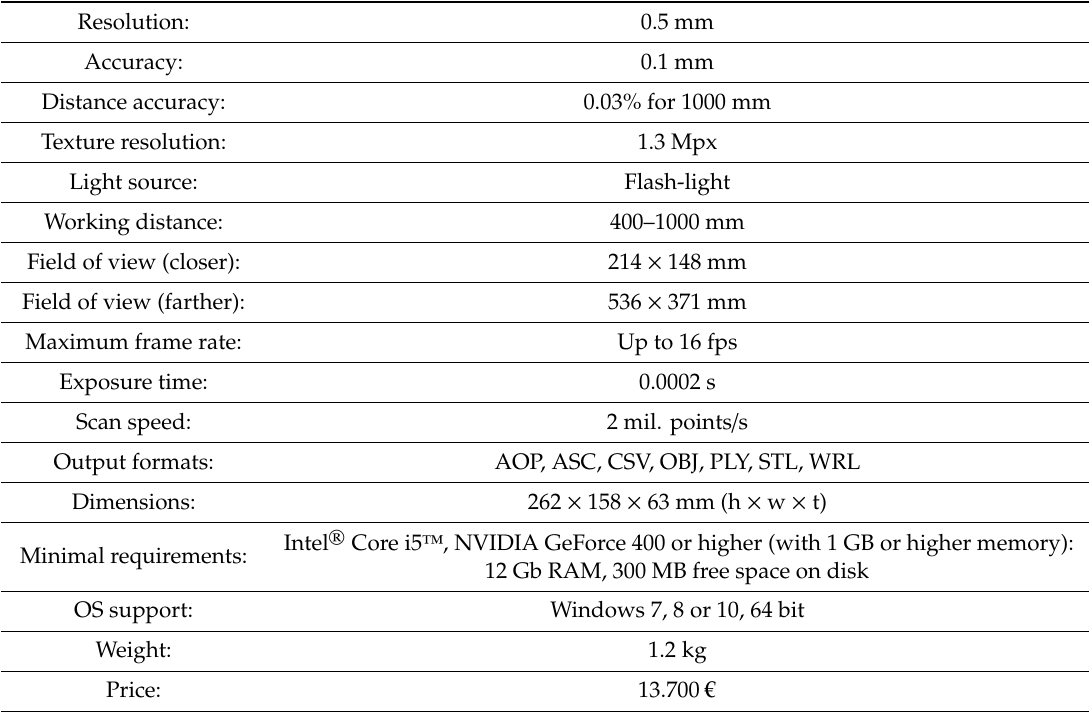
Table 1. Basic parameters of the Artec Eva scanner [9,17].